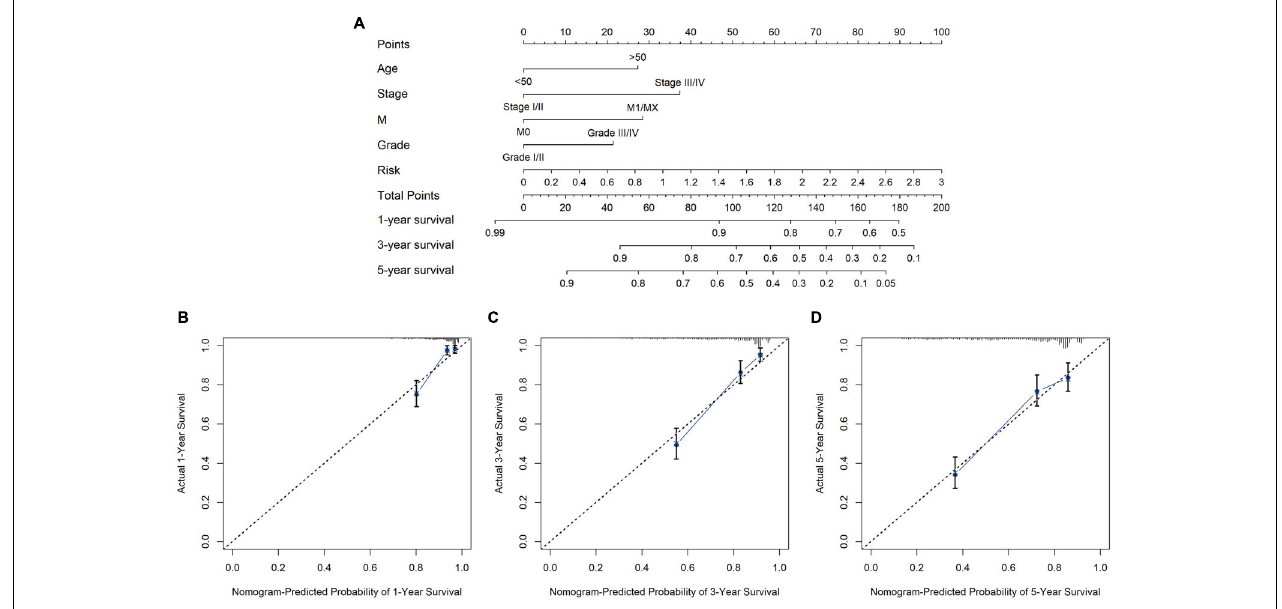
FIGURE 6 | Nomogram and calibration plots. (A) 1 − , 3 − , and 5-year OS predicted by the nomogram. (B) Calibration curves for the prediction of 1-year OS. The probability of survival predicted by the nomogram plotted on the x-axis and actual survival on the y-axis. (C) Calibration curves for prediction of a 3-year OS. (D) Calibration curves for prediction of a 5-year OS.